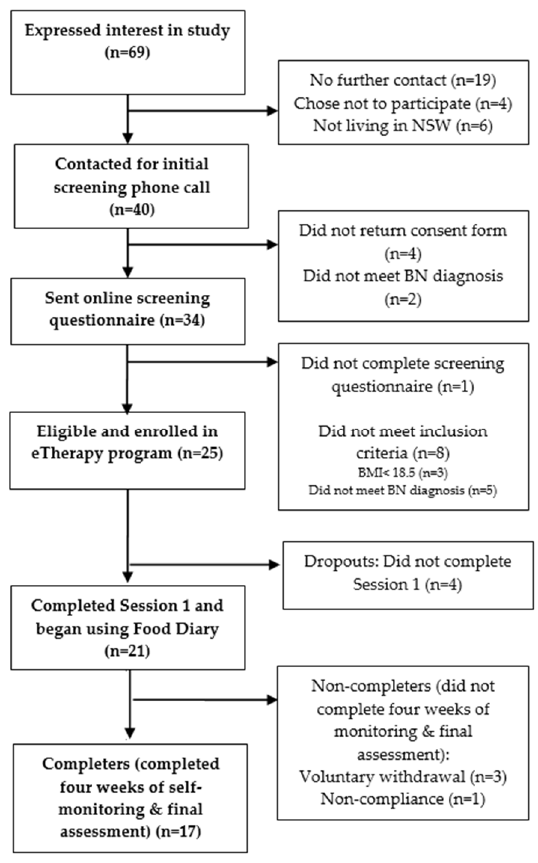
Figure 1. Flowchart of study participants.